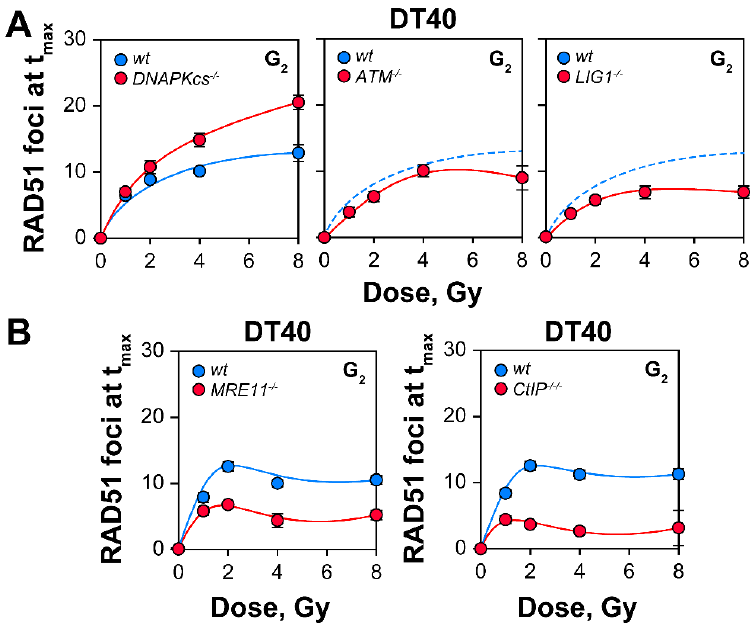
Figure 6. RAD51 foci in DT40 cells with various DSB repair defects: ( A ) Formation of RAD51 foci in DT40 cells deficient in factors involved in DSB-processing (DNAPKcs, ATM and LIG1); ( B ) RAD51 foci in DT40 cells deficient in the essential factors involved in DNA end-resection (MRE11 and CtIP). G 2 -phase cells were enriched by centrifugal elutriation. Data represents the mean and standard deviations from 3 independent determinations.